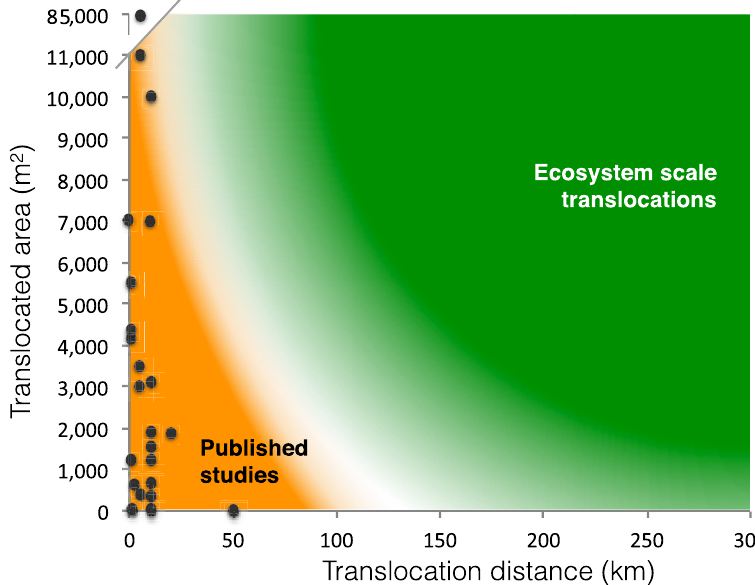
Figure 2. Conceptual diagram of the size of the area translocated in relation to translocation distances. The orange area corresponds to typical past and current habitat translocation projects, with dots corresponding to published studies (see Supplementary material S1 for a complete list). The green area represents an ideal combination of size and distance for ecosystem-scale translocation, with darker green more suitable, although more difficult to put in place.